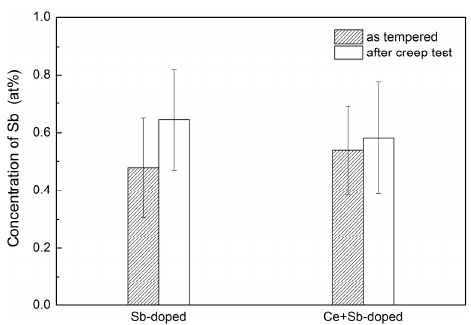
Figure 7. Grain boundary concentrations of Sb in the Sb-doped and Sb+Ce-doped specimens as tempered and creep tested (the Sb-doped specimen ruptured after 423 h and the Sb+Ce-doped specimen ruptured after 601 h. The error bar represents the standard deviation).